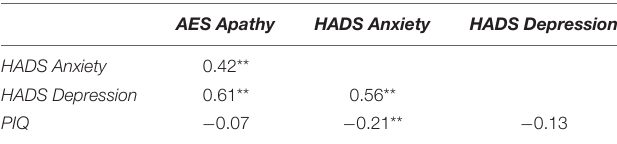
TABLE 4 | Correlation matrix of apathy, mood, and